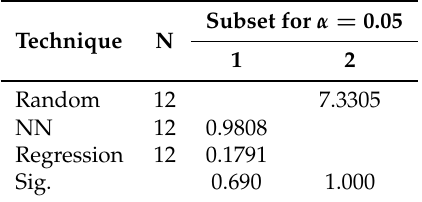
Table 16. Duncan: Homogonous final solutionsubset.